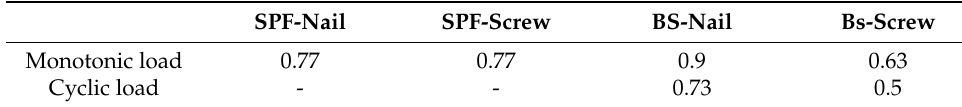
Table 8. Value of modification factor η lp